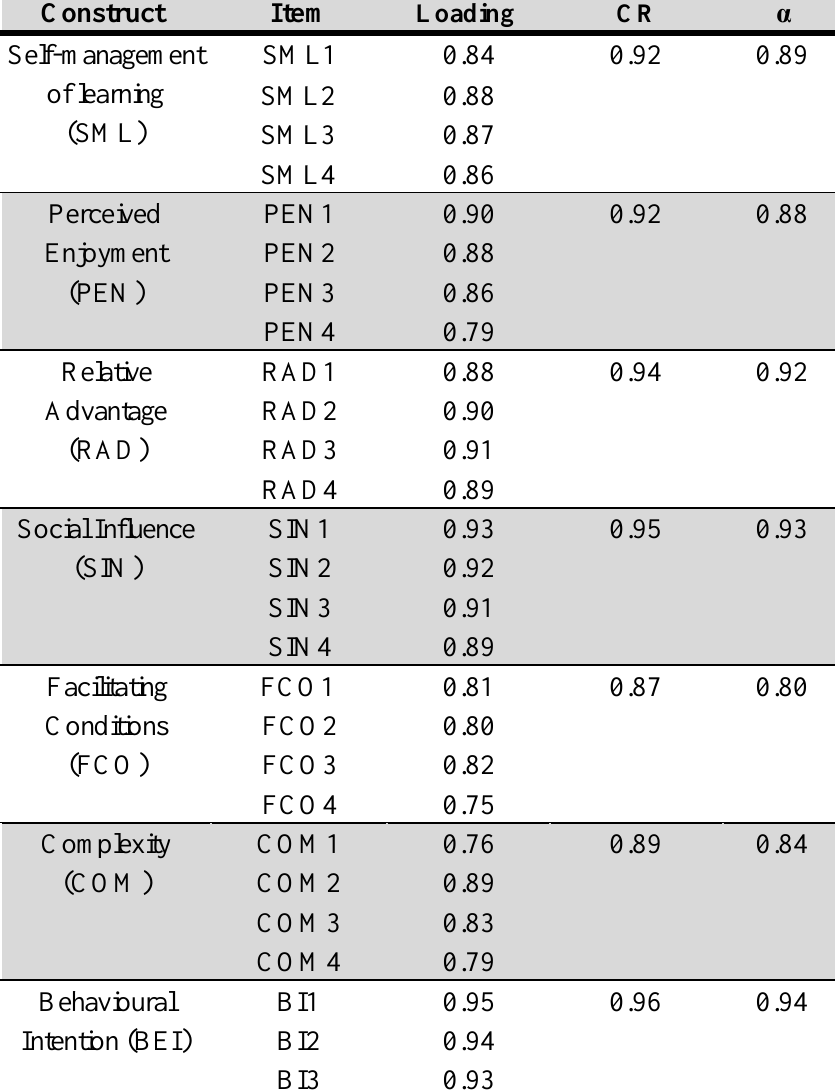
Table 3 The Measurement Model Analysis